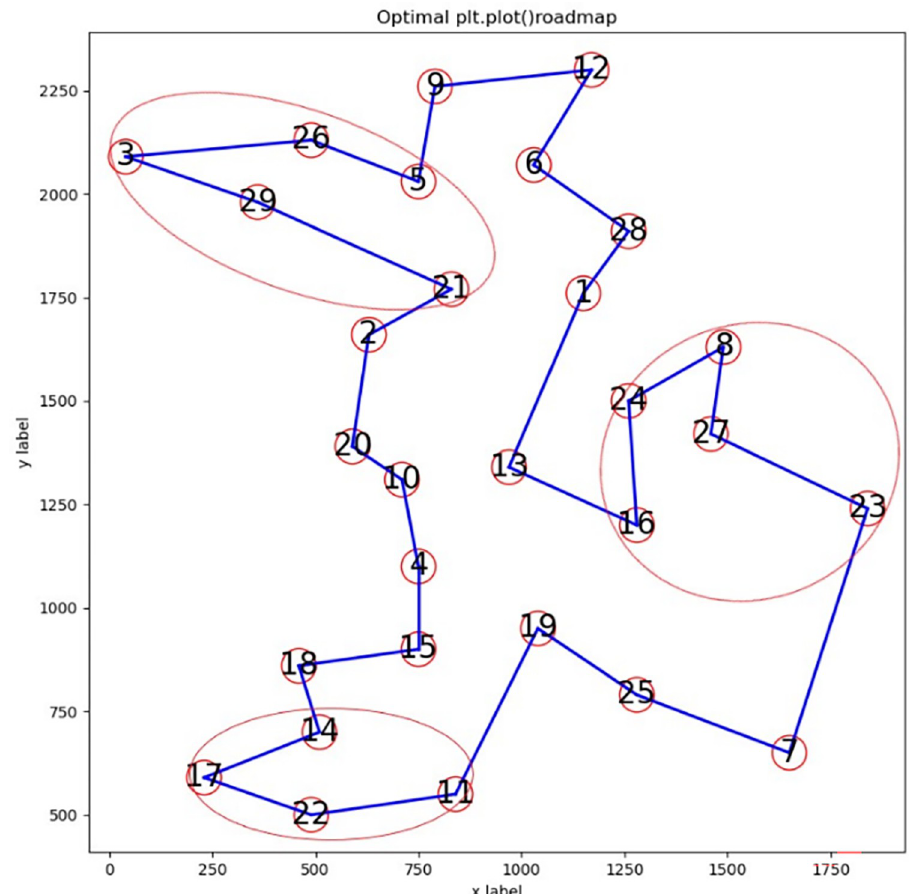
Fig 2. Optimal route of